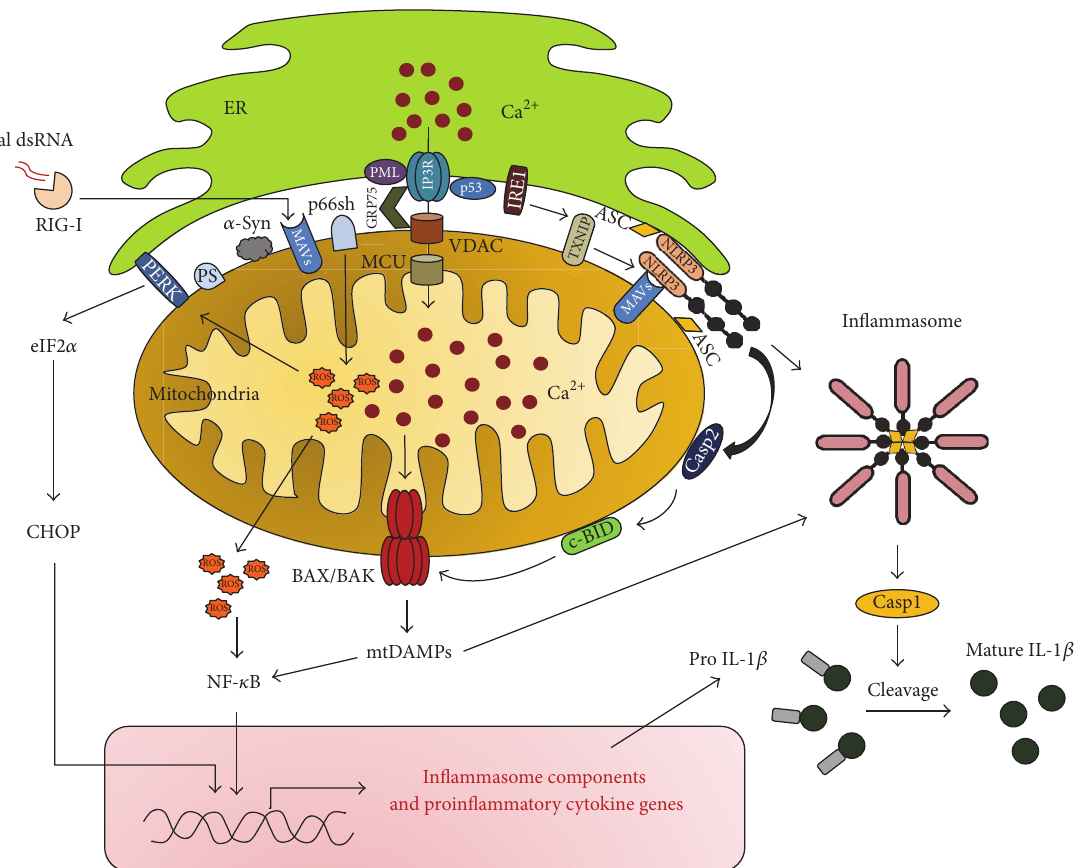
Figure 2: Mitochondria-associated ER membrane as an inflammatory signaling hub. Close contact between the endoplasmic reticulum (ER) and mitochondria via mitochondria-associated ER membrane (MAM) formation allows the ER calcium channel IP3R to funnel calcium into mitochondria by forming a complex with the chaperone protein GRP75 and the mitochondrial outer membrane calcium channel VDAC. Then, the inner mitochondrial membrane calcium channel MCU injects calcium into the mitochondrial matrix. Under pathological conditions, elevated ER-mitochondrial interaction promotes calcium accumulation via proteins present at the MAM interface. The MAM-resident proteins PML and p53 control ER calcium release by physically interacting with IP3R. In addition, p66sh amplifies mitochondrial ROS production. Increased cellular ROS activates NF- 𝜅 B, a master regulator of inflammation, resulting in increased expression of genes encoding numerous proinflammatory cytokines. PERK plays a dual role by tethering ER and mitochondria and detecting ROS dependent mechanism. NLRP3 detects mitochondrial ROS generation and recruits caspase-2 (Casp2) to mitochondria to cleave BID, forming c-BID, which in turn promotes BAX/BAK-mediated mtDAMP release. NLRP3 activation also promotes recruitment of ASC to